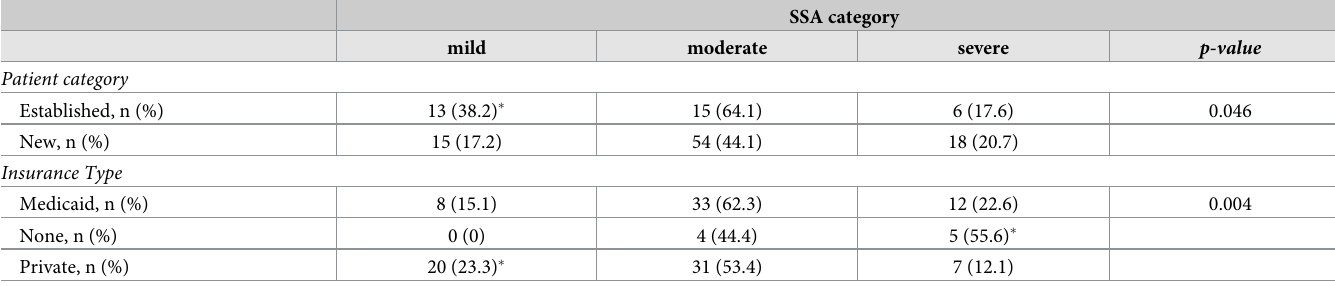
Table 2. Categorical analysis of SCFE severity in patient category and insurance